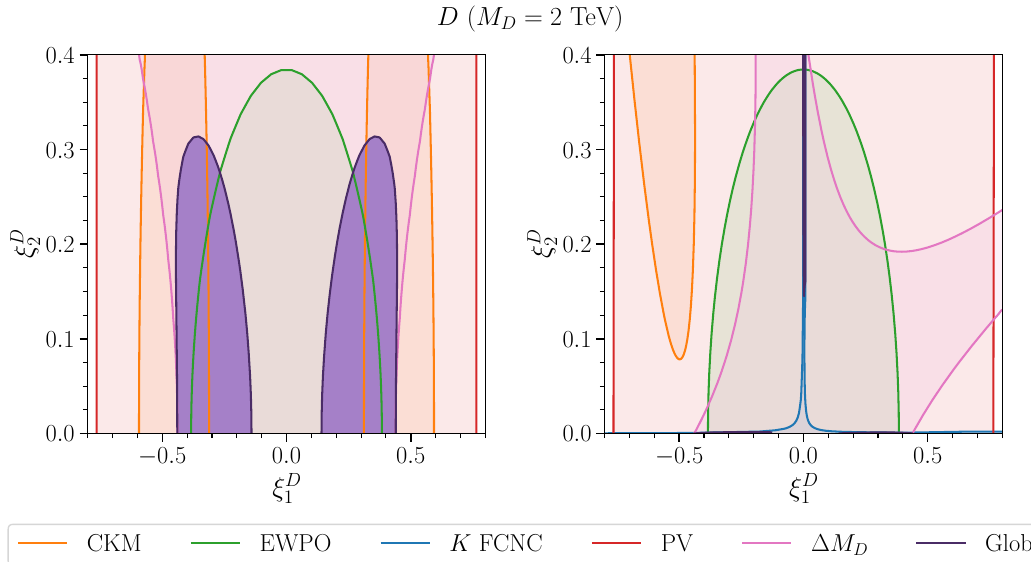
Figure 9 . Global fit to 1 st and 2 st generation couplings of the VLQ D . The left-hand side assumes multiple generations of VLQs, each only coupling to a single generation (i.e. effectively removing constraints from kaon physics), while on the right side this assumption is removed.